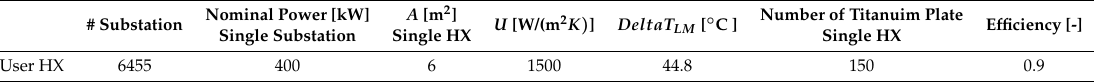
Table 4. Main parameters for substation heat exchanger sizing.